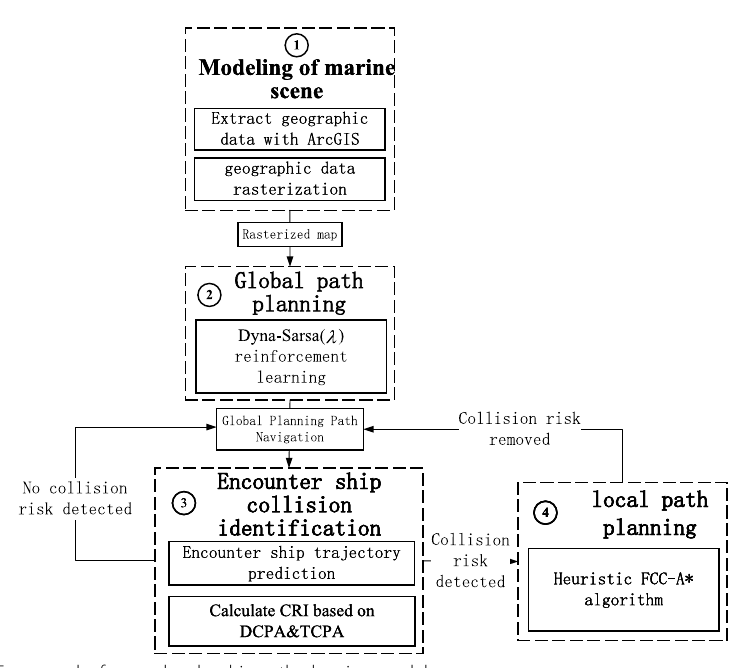
Fig. 2 Framework of second-order ship path planning